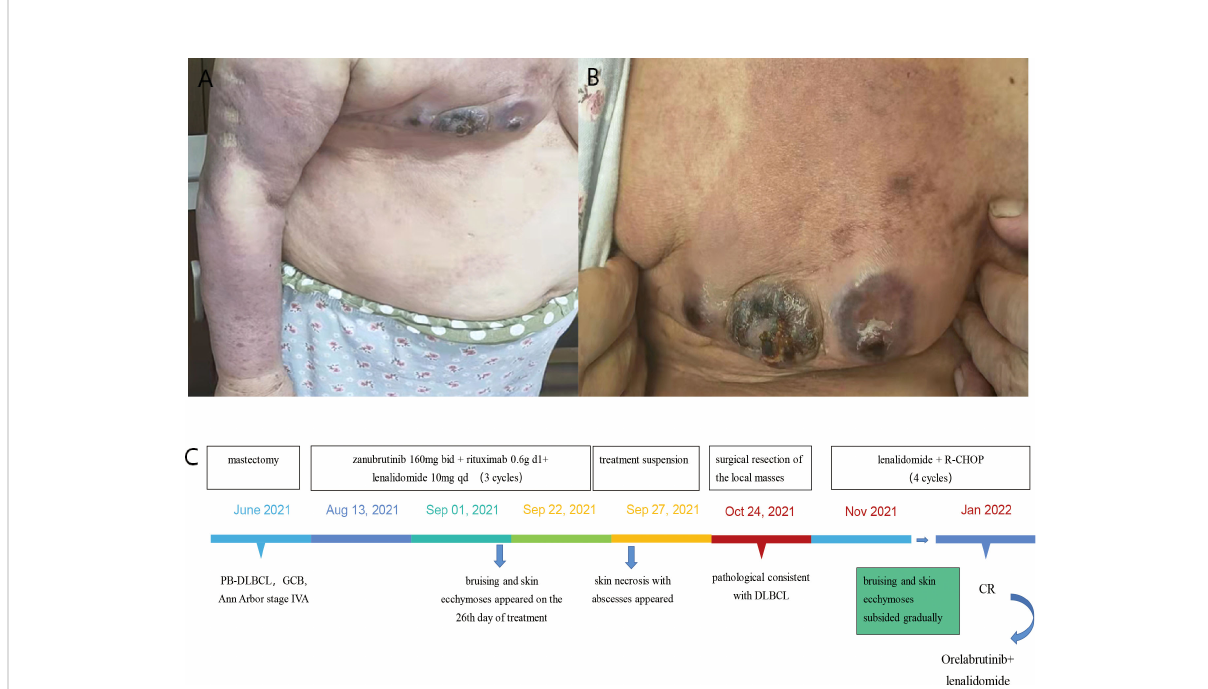
FIGURE 1 Case 1 : A 71-year-old woman with PB-DLBCL. (A) swelling of the right upper extremity. (B) bruising and skin ecchymoses on the right upper extremity and the right anterior chest wall. (C) The time line of this